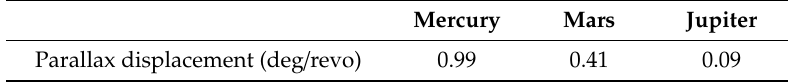
Table 1. Parallax displacements for Mercury, Mars and Jupiter during one orbital revolution of Arase.